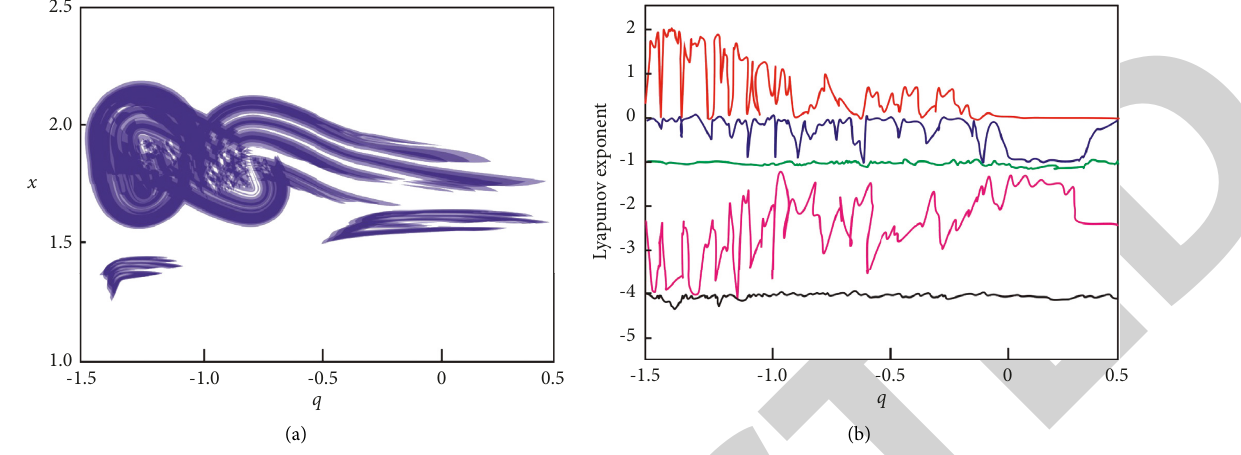
Figure 6: The system shows the branch diagram and Lyapunov index spectrum varying with the parameter q : (a) branch diagram; (b) Lyapunov exponent